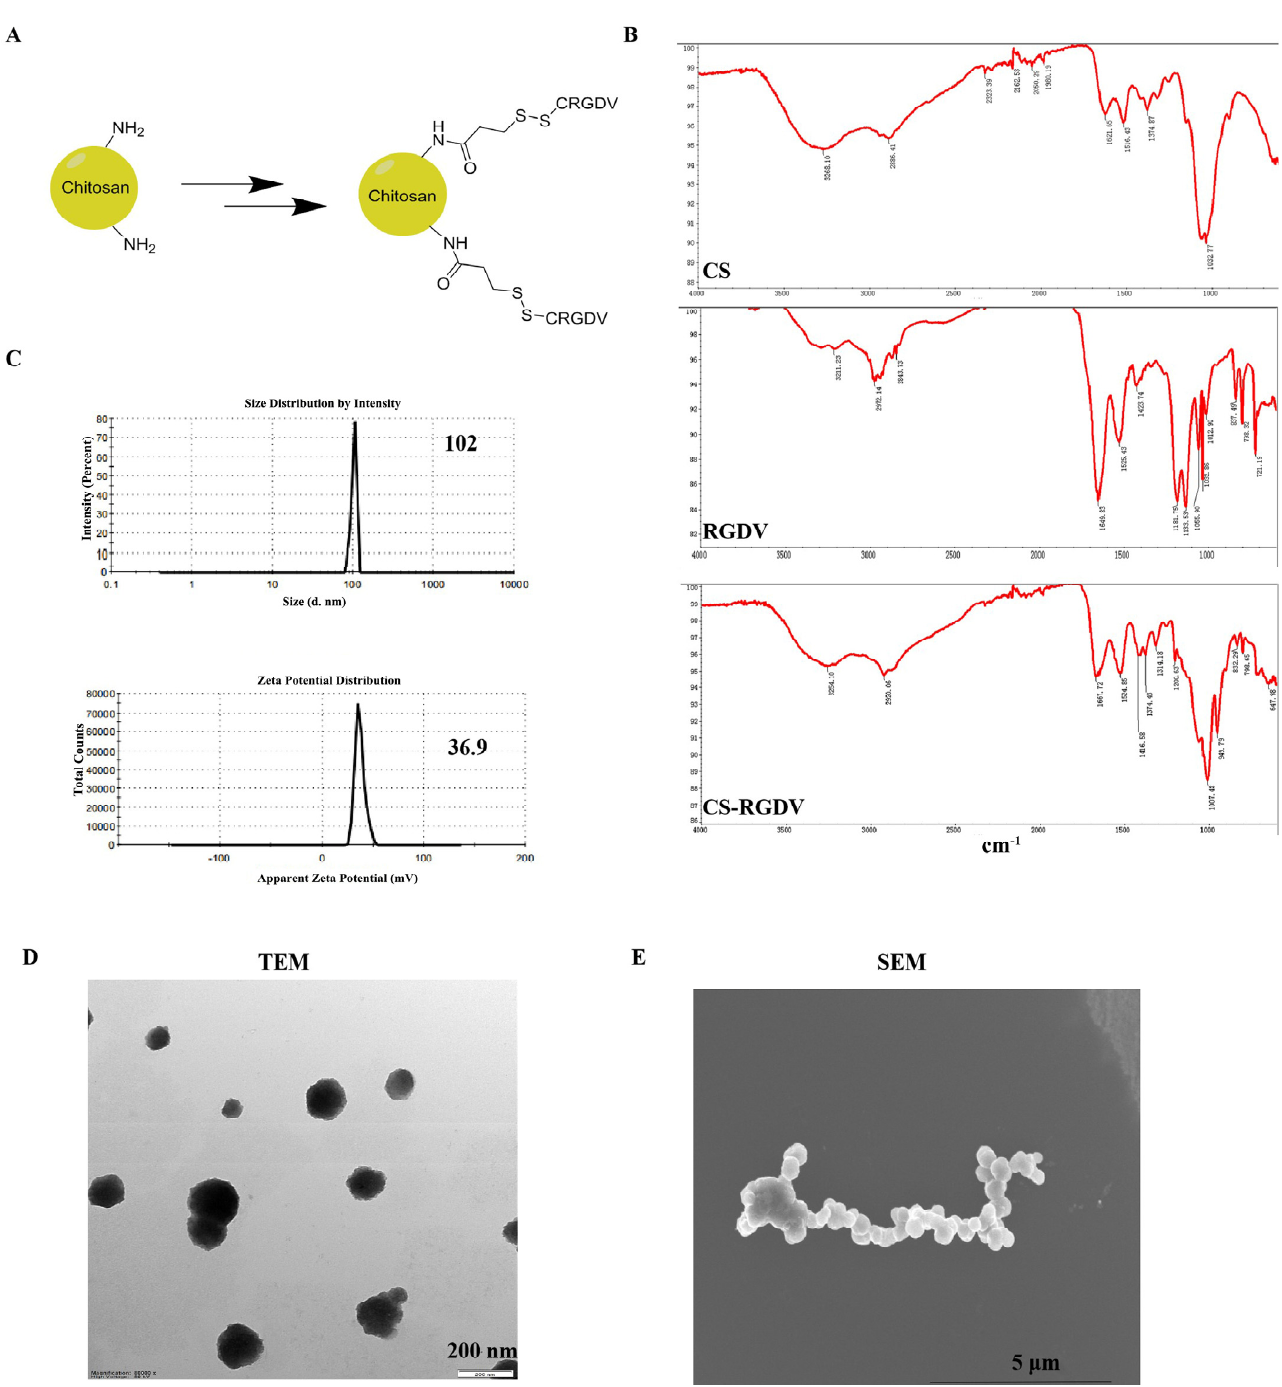
Figure 1. Characterization of chitosan-modified peptide nanoparticle. ( A ) Schematic illustration of the synthesis process of chitosan-modified peptide nanoparticles. ( B ) IR spectrum of RGDV peptide, chitosan (CS), and chitosan-modified peptide (CS-V). ( C ) Size distribution and zeta potential of CS-V. ( D ) TEM image of CS-V. ( E ) SEM image of CS-V.